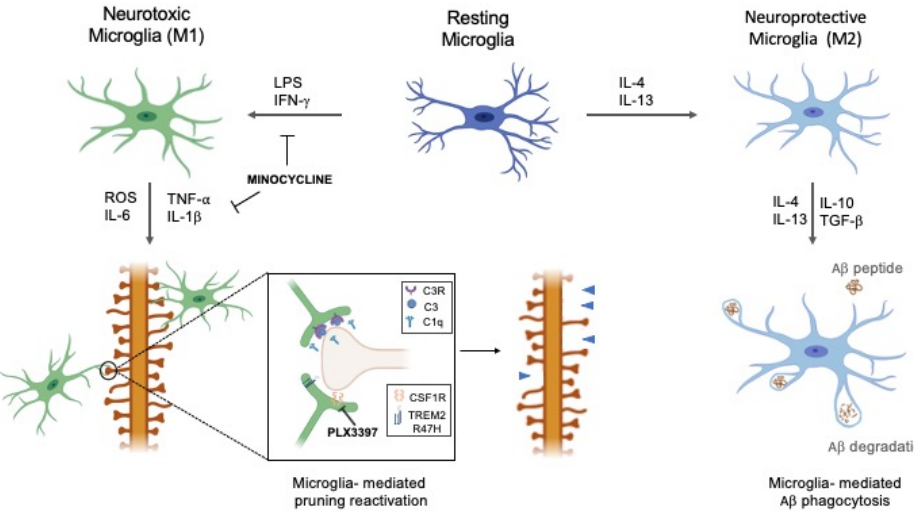
Figure 1. The dual role of microglial phenotypes in Alzheimer’s disease (AD). Depending on the received stimuli, resting microglia can shift to either neurotoxic (M1) or neuroprotective (M2) phenotype. Activated M2 microglia participate in the clustering of amyloid beta (A β ) plaques and their consequent phagocytosis. Overproduction of pro-inflammatory cytokines by M1 can reactivate microglia-mediated pruning, aided by C1q and C3, leading to pathological synaptic loss. Minocycline can modulate the pathological activation of M1 phenotype and lock the pro-inflammatory mediators’ release, thereby reducing inflammation. The modulation of colony-stimulating factor 1 receptor (CSF1R) and triggering receptor expressed on myeloid cells 2 (TREM2) R47H receptors expressed by microglia, e.g., through CSF1R inhibitor Pexidartinib (PLX3397) administration, could exert a protective role in preventing microglia-mediated pruning reactivation.